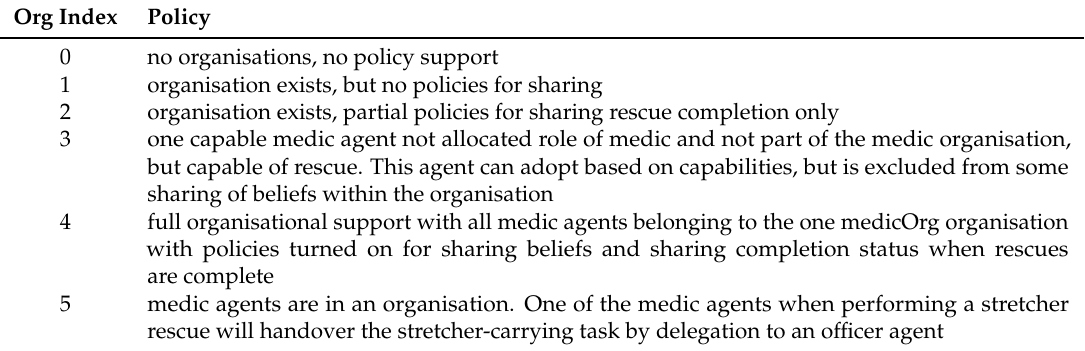
Table 5. Organisation support level policy settings—4-room